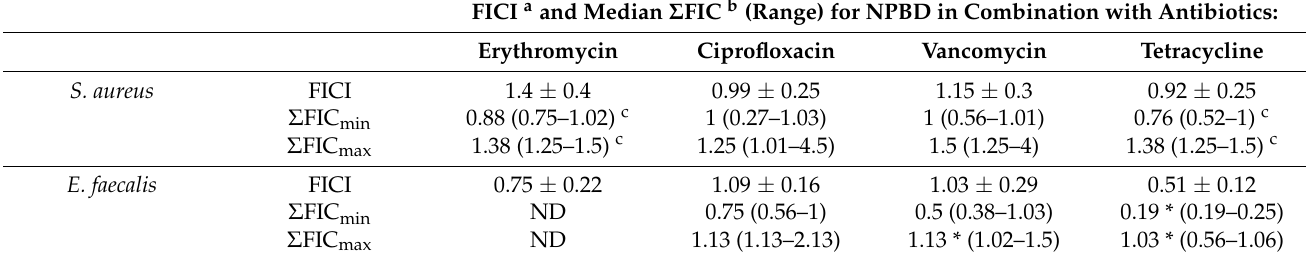
Table 3. Antibacterial efficacy of NPBD/antibiotic combinations for S. aureus and E. faecalis . FICI a and Median Σ FIC b (Range) for NPBD in Combination with